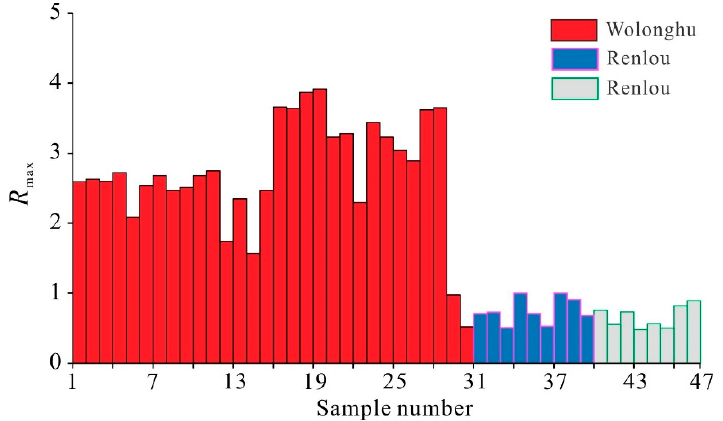
Figure 2. Distributions of maximum vitrinite reflectance of coals from the Huaibei Coalfield.